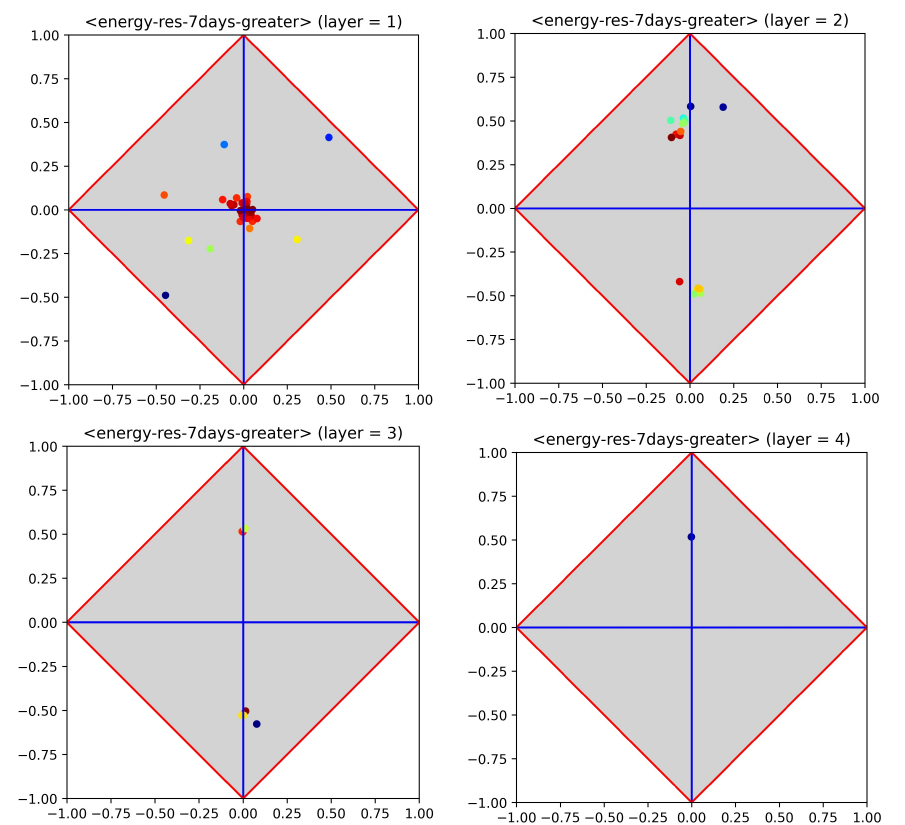
Figure 7. Hidden layers of an MLP trained on the dataset relating to residential customers (full set of features). The focus was on predicting whether the next-hour load would be greater than the previous one.